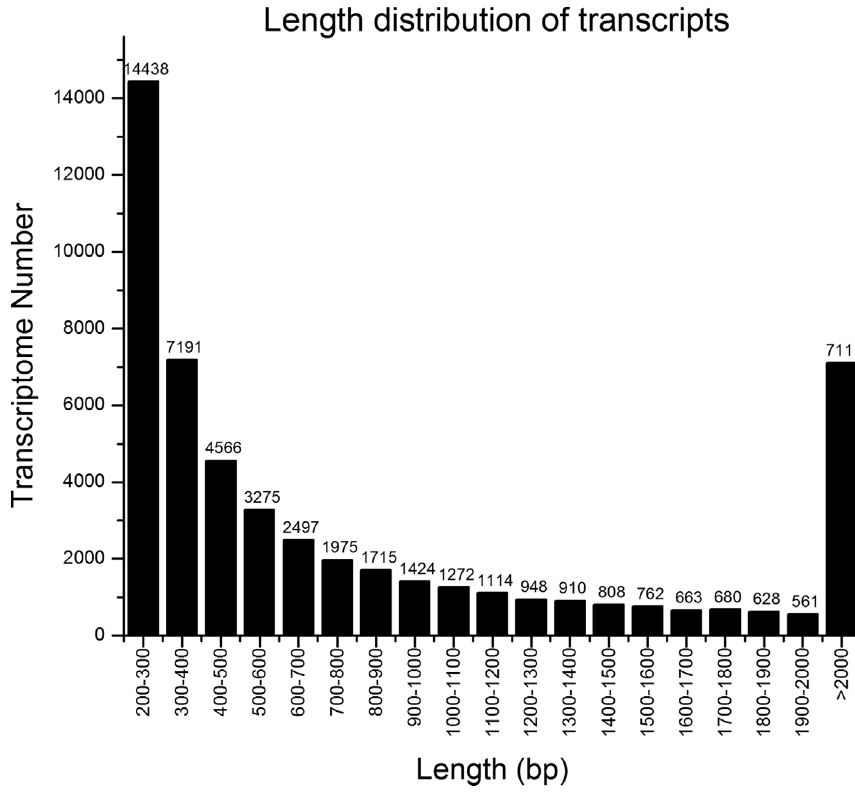
Figure 1 - Length distribution of Lymantria dispar transcripts.